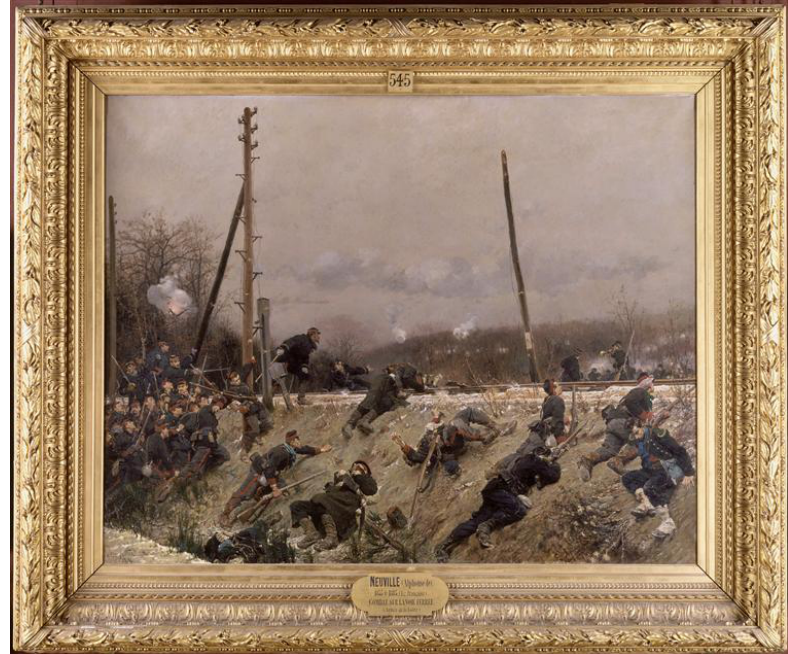
Figure 1. Alphonse de Neuville (1835–1885), Combat sur une voie ferrée ; armée de la Loire , 1870–1871, oil on canvas, 172 cm × 216 cm, Chantilly, musée Condé, PE545. Neuville exhibited this painting at the 1874 Salon, with no. 1390. (Used by